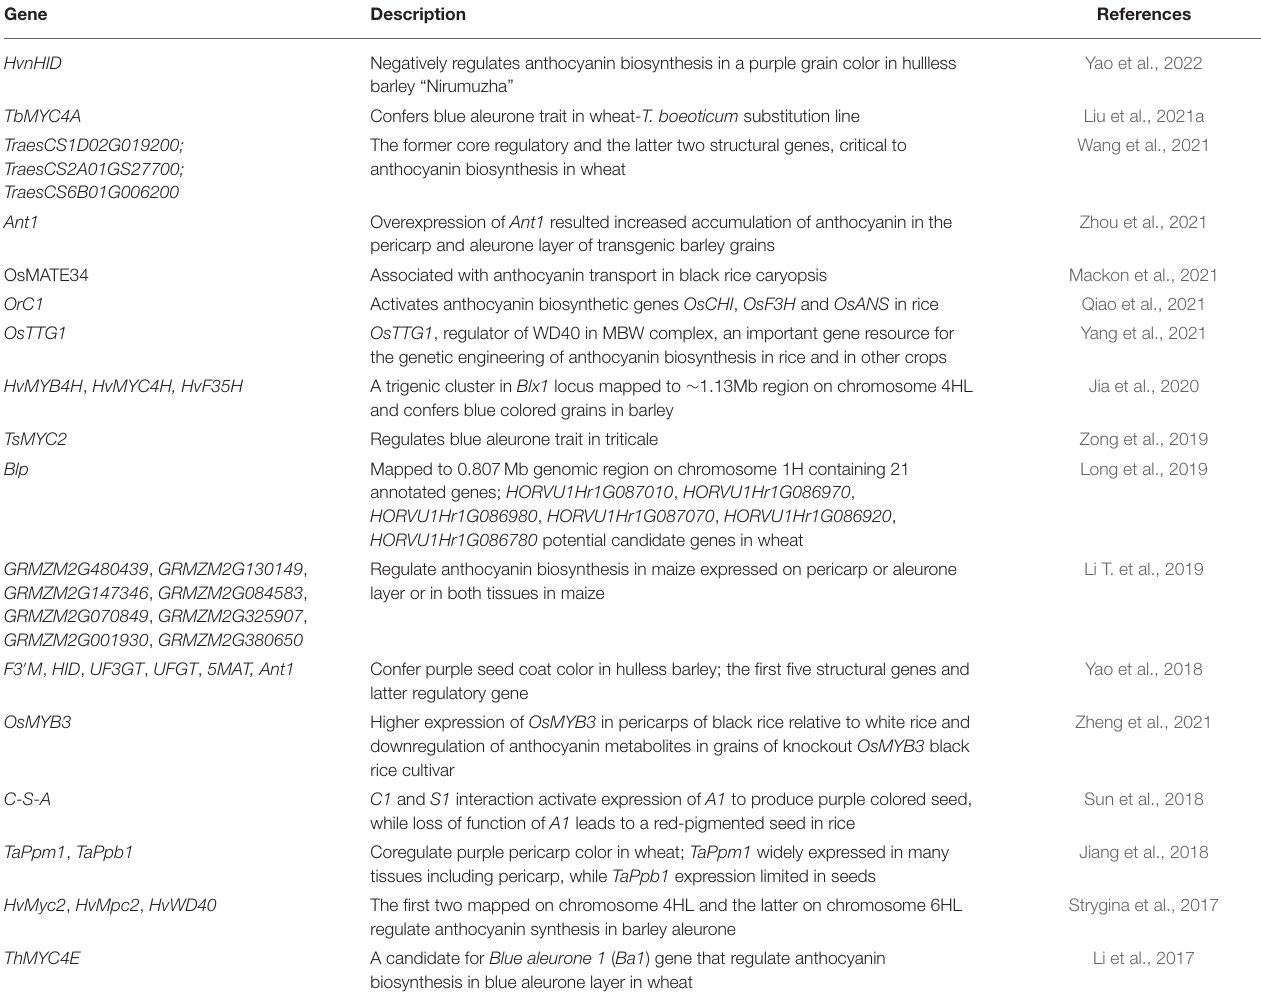
TABLE 3 | Candidate or functionally characterized genes regulating anthocyanin biosynthesis in barley, maize, rice, and wheat.